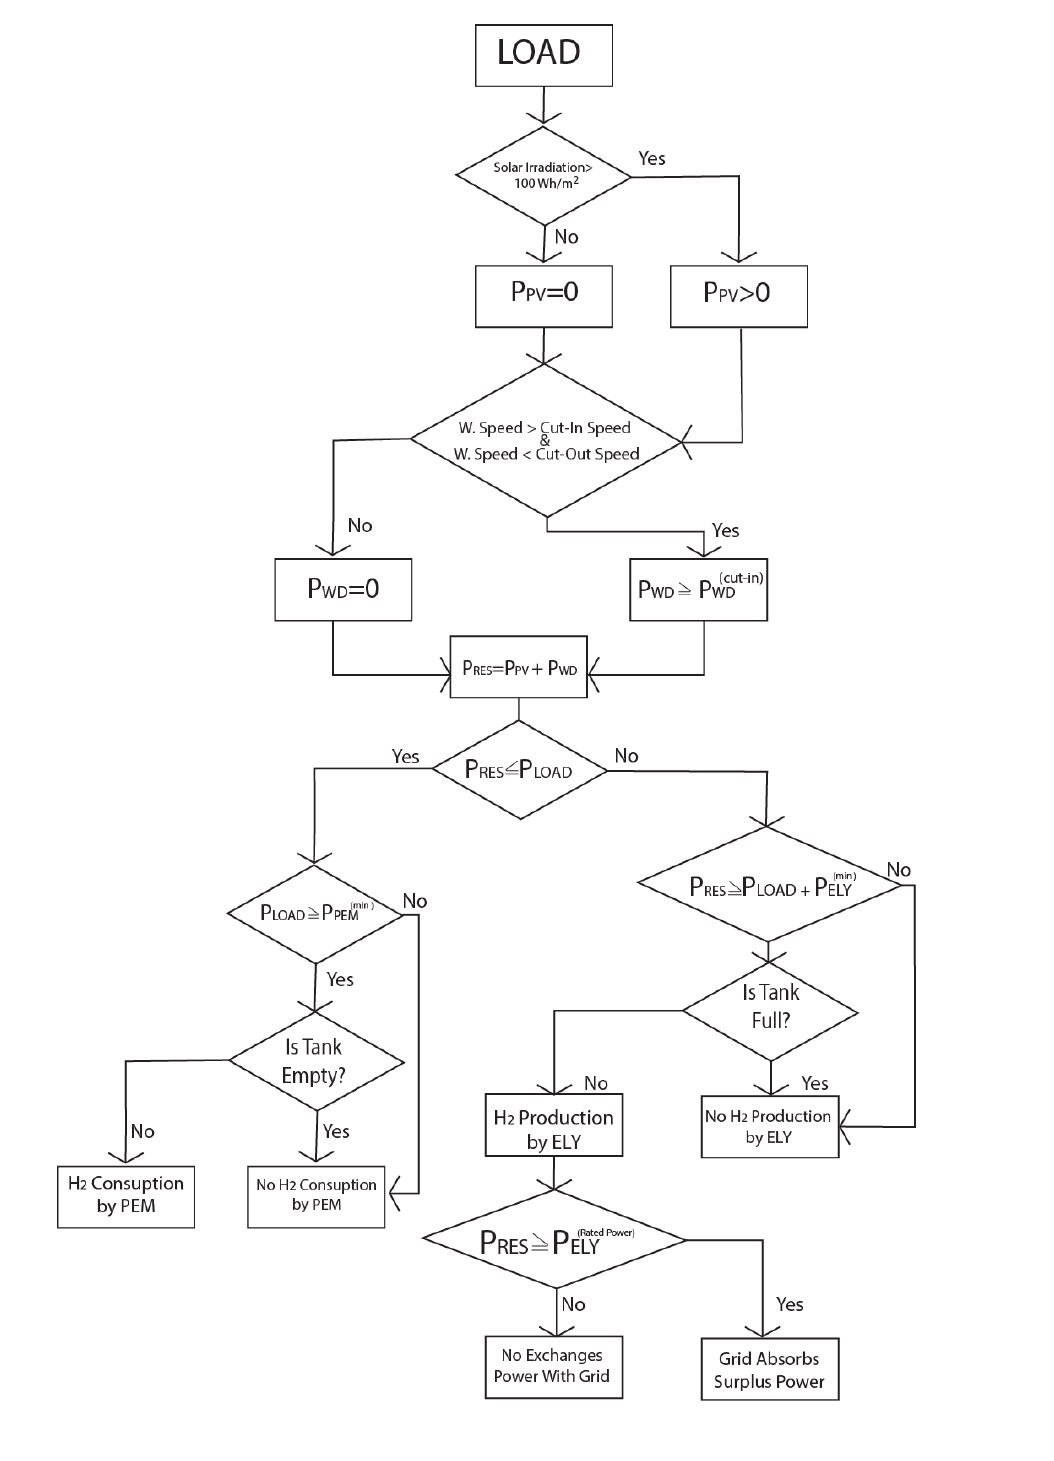
( cut − in ) : Wind power WD ( min ) : Minimum ELY